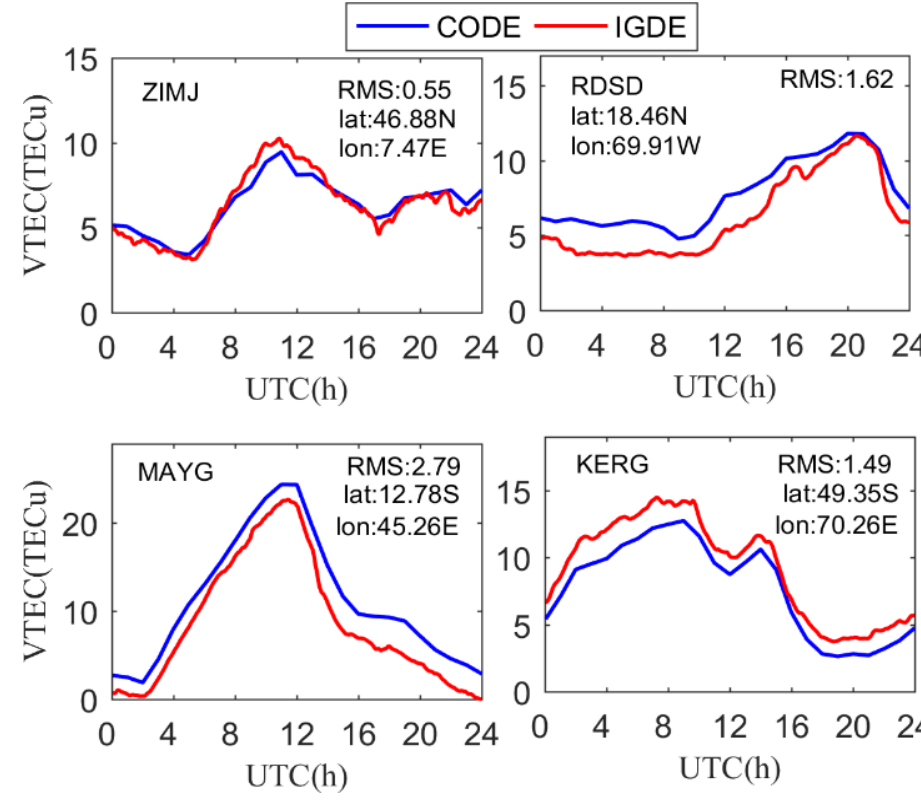
Figure 5. VTEC series value of the IGDE and CODE product for the four stations on DOY 011. As can be seen from Figure 5, the series value of VTEC obtained by IGDE and CODE showed the same trend throughout the whole day, which indicates that the VTEC of the station obtained by IGDE can show the variation in TEC at the station. However, the performance of IGDE may have been different at different stations. It is obvious that for stations ZIMJ and KERG, the RMS of VTEC was within 1.5 TECU. However, the RMS of RDSD and MAYG was larger than that of other stations, mainly since they are in the equator area with active ionospheric variation. Figure 6 shows the mean difference and RMS of VTEC between the IGDE and CODE product at all MGEX stations on DOY 011, 2019. For most stations, the mean difference and RMS were within ± 3 TECu and 3 TECu, respectively. However, the stations located in the low-latitude area, whose mean difference and RMS showed a larger value, showed the same phenomenon, as depicted in Figure 5. few observations at those stations. The accuracy of TEC from CODE was 2–8 TECu [10], and the mean values of the difference and RMS were − 0.25 and 2.28 TECu for all stations, respectively, indicating good performance of the proposed method in VTEC estimating for those